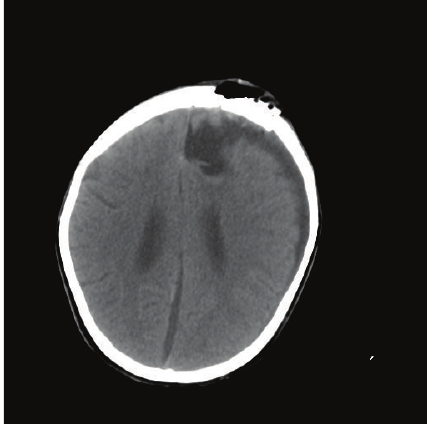
Figure 4: Primary brain CT scan that shows unilateral frontal brain abscess (confined to one